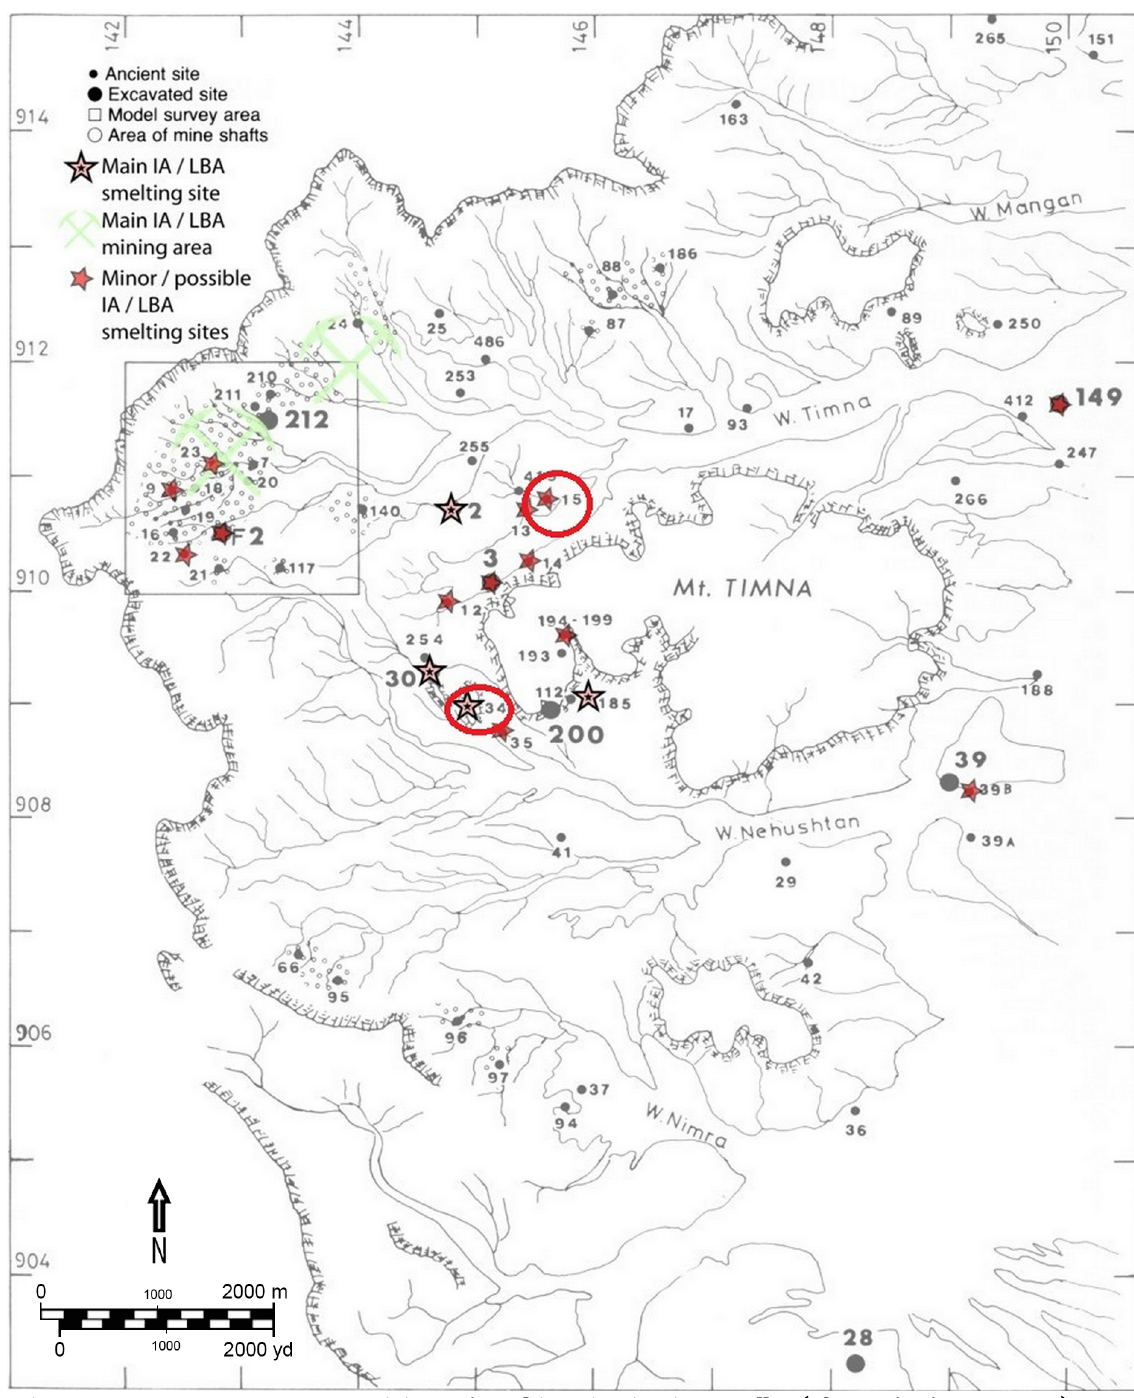
Figure 2. Late Bronze or Iron Age mining and smelting Sites in Timna Valley (after Rothenberg 1990: